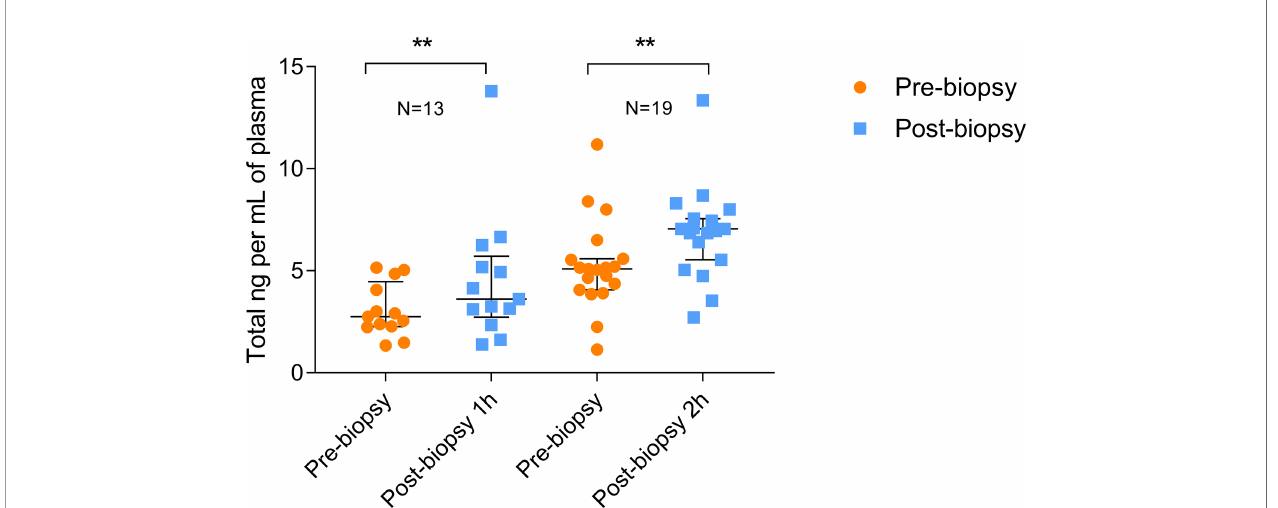
FIGURE 1 | Quantitation of pre- and post-biopsy ccfDNA from blood. ccfDNA extracted from blood immediately before the biopsy and after 1 or 2 hours from the end of the procedure. Scatter plots (with median and interquartile range) show the amount of ccfDNA expressed as ng/mL of plasma. The number of analyzed individuals in shown above the plots (** P<0.01; Wilcoxon test for paired samples).